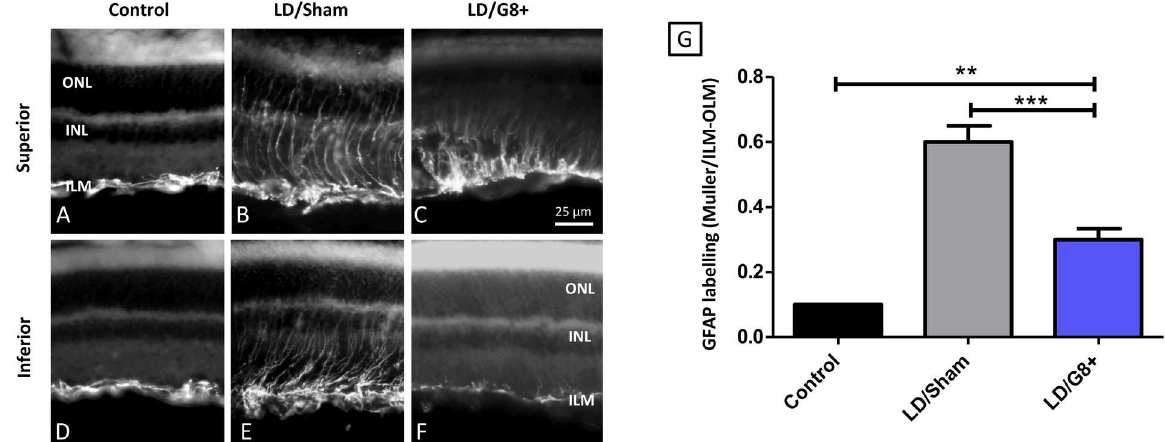
Fig 6. Myo/Nog cell injections mitigated retinal stressfollowing LD, as measuredby GFAP expression. (A-F) Representative sections from superior and inferior retina of control (non-lightdamaged)and light damagedeyes injected with PBS (LD/Sham) or G8 + cells (LD/G8+). Sections were labeledwith an antibodyto GFAP (white). ILM–inner limiting membrane; INL- inner nuclear layer; ONL–outer nuclear layer; OLM–outer limitingmembrane. (G) Normalisedlengthof GFAP labelingfor control as measuredby the length of the labeledMuller cells normalized to the length of the nuclear retina. Error bars show SEMs. Non-LDretinas had significantly shorter GFAP+ labeledMullercells than LD retinas (asterisk with p value). Injectionof G8+ cells followingLD had significantly shorter Muller cells than LD retinas injected with PBS. (Control, n = 5; LD/Sham, n = 4; LD/G8+ = 9). *** indicatesp < 0.001; ** indicates p < 0.01.